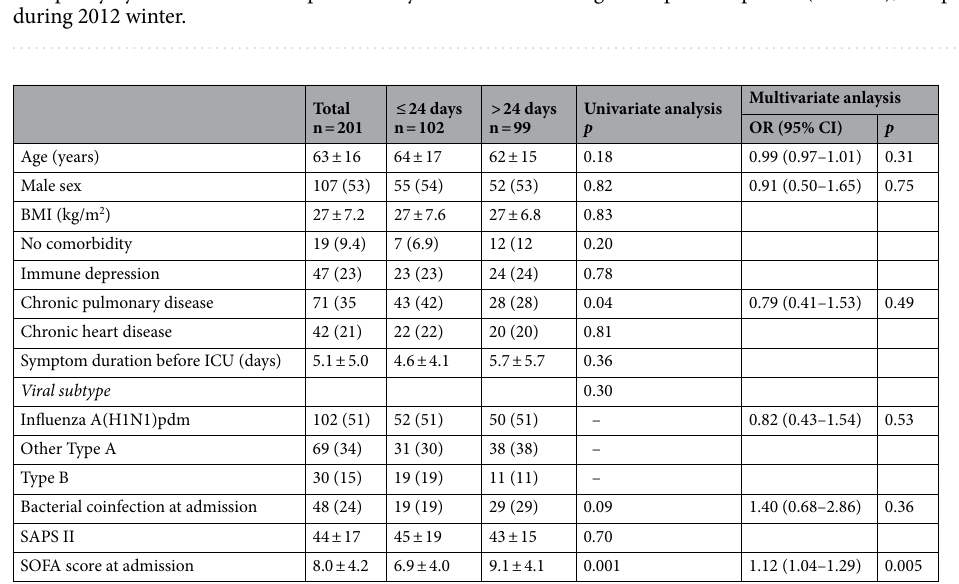
Figure 1. Weekly rate of ICU bed occupancy by Influenza-infected patients. At the peak of ICU activity, bed occupancy by Influenza-infected patients stayed below 10% during each epidemic period (blue bar), except during 2012 winter.